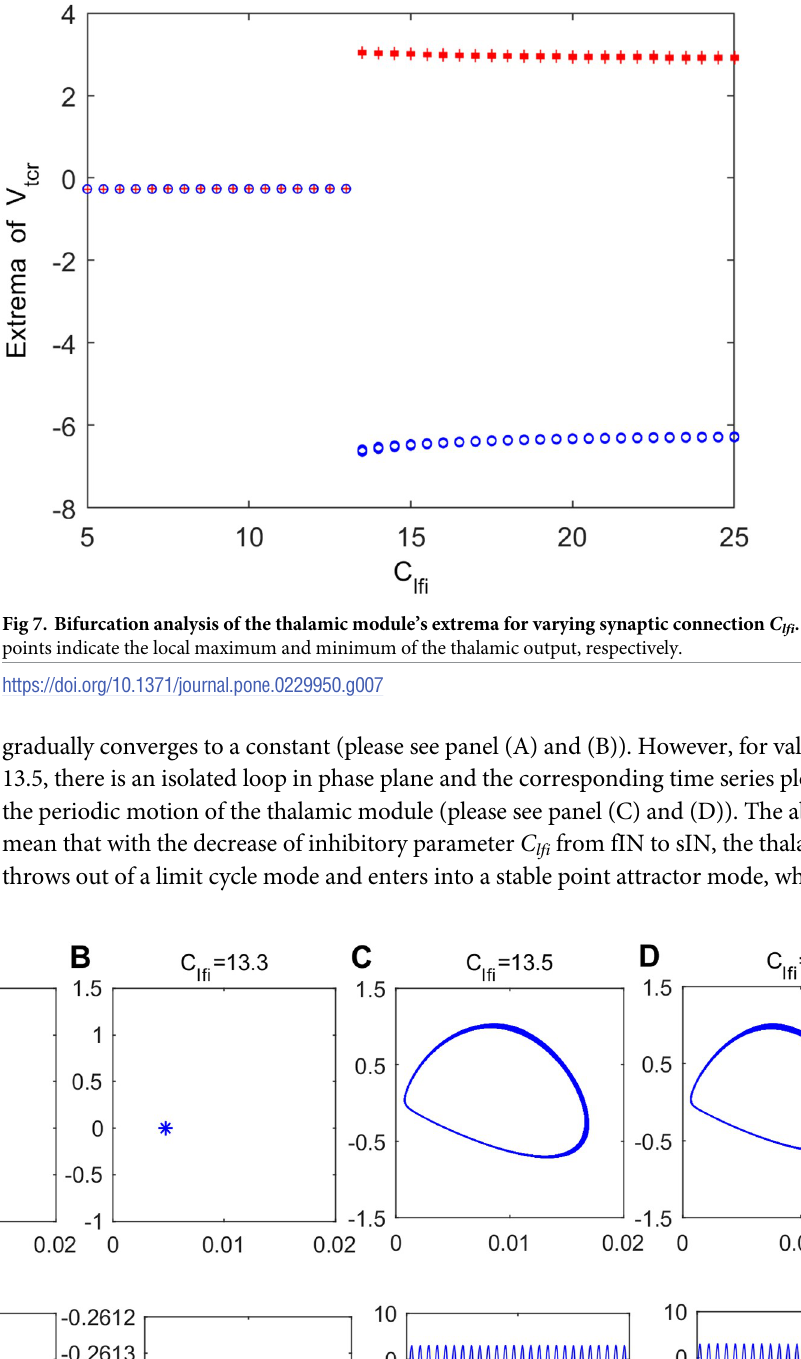
takes different values. lfi